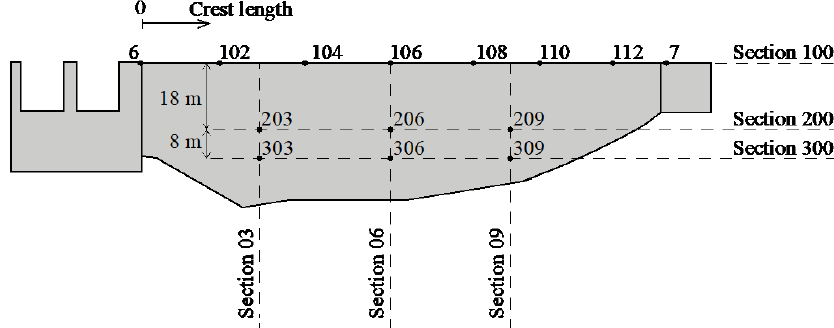
Figure 2. Downstream view of the arch dam with the spillway shown to the left and the abutment block to the right. The monitoring points are also shown where section 100 is at the crest and Section 06 is in the central part of the dam. Reproduced from [17].